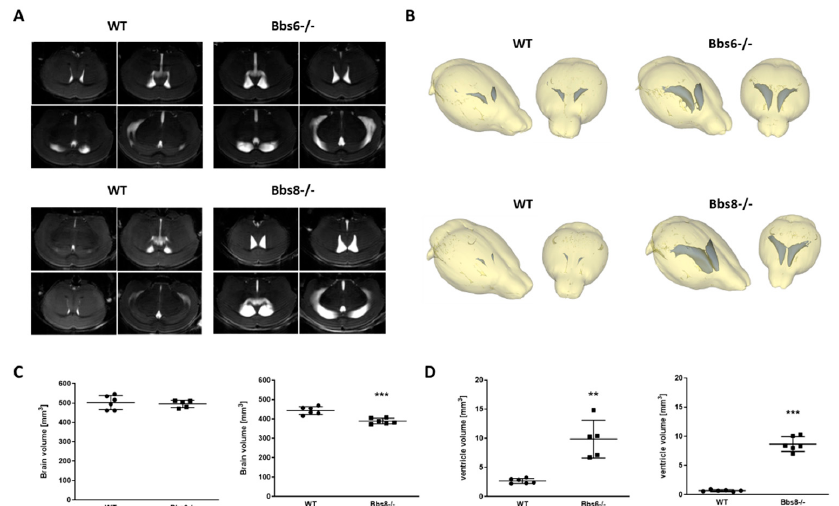
Figure 1. Increased volume of lateral ventricles in Bbs6 and Bbs8 knockout mice. ( A ) Mice were anesthetized with isoflurane and subjected to MRI ( n = 6 for wild type (WT) and 5 for Bbs6 − / − ; n = 6 for WT and Bbs8 − / − ; 40% females in the Bbs6 − / − group, for all other groups 50% females). ( B ) MRI images were used for a three-dimensional modelling of the brain structure and volumetric analysis of brain and lateral ventricle size. Quantitation of brain ( C ) and ventricle volumes (sum of both lateral ventricles ( D )). Student’s unpaired t -test was used for statistical analysis (** p < 0.01; *** p < 0.0001).